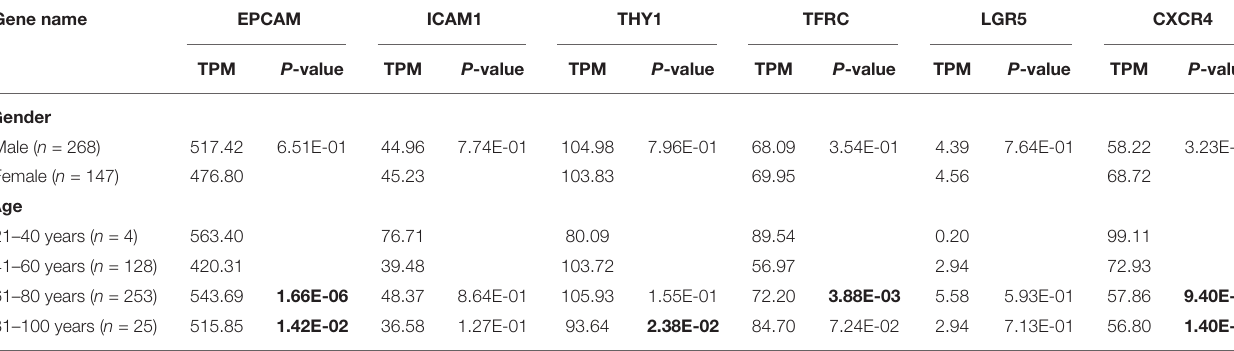
TABLE 1 | Expression of GCSC markers in GC patients with distinct genders and ages